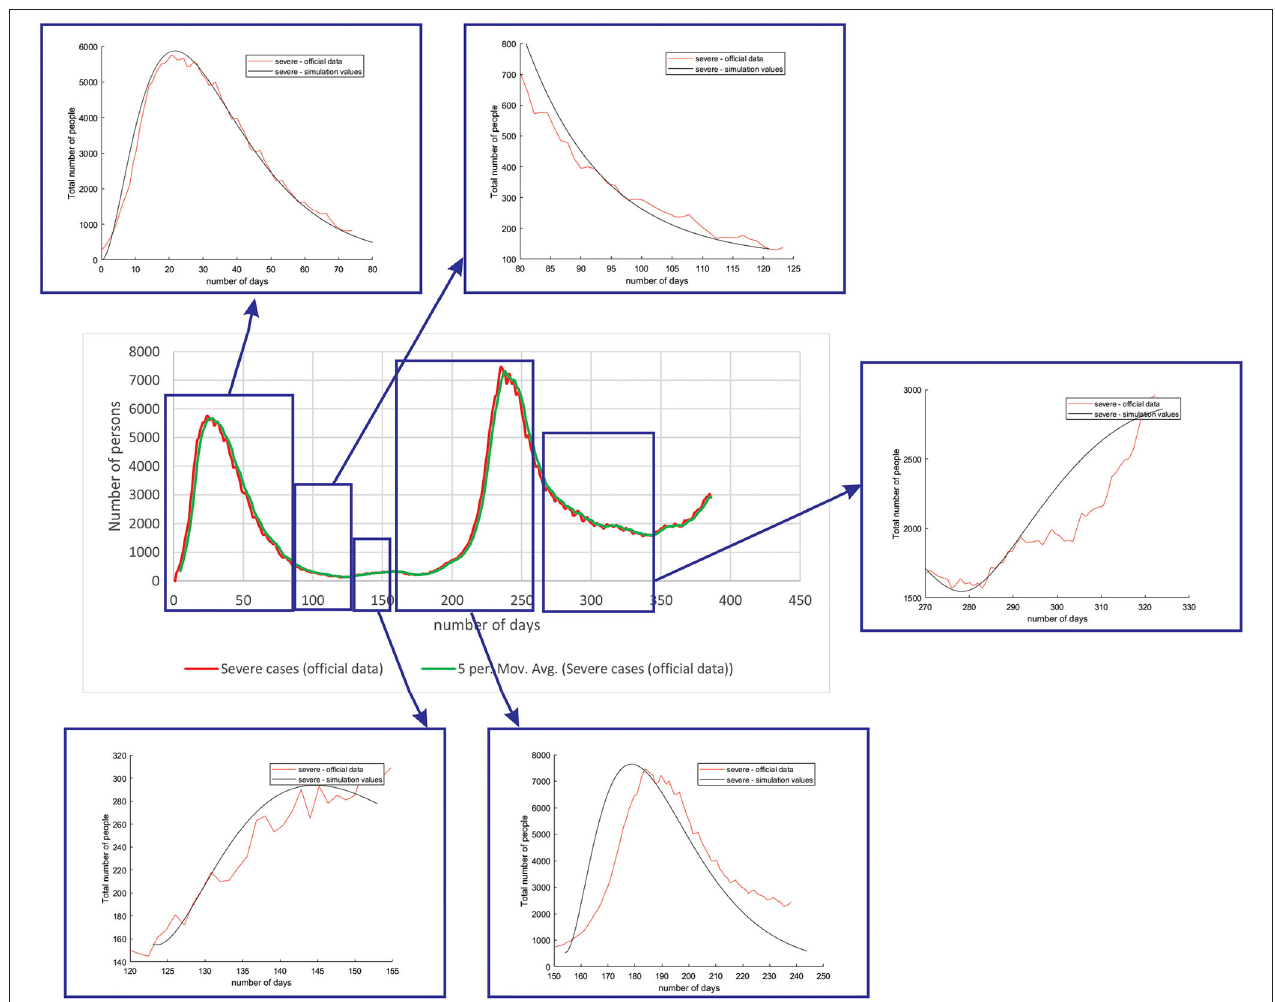
FIGURE 5 | Comparison between the real and simulated values for severe cases in Belgium using the proposed SEIRD